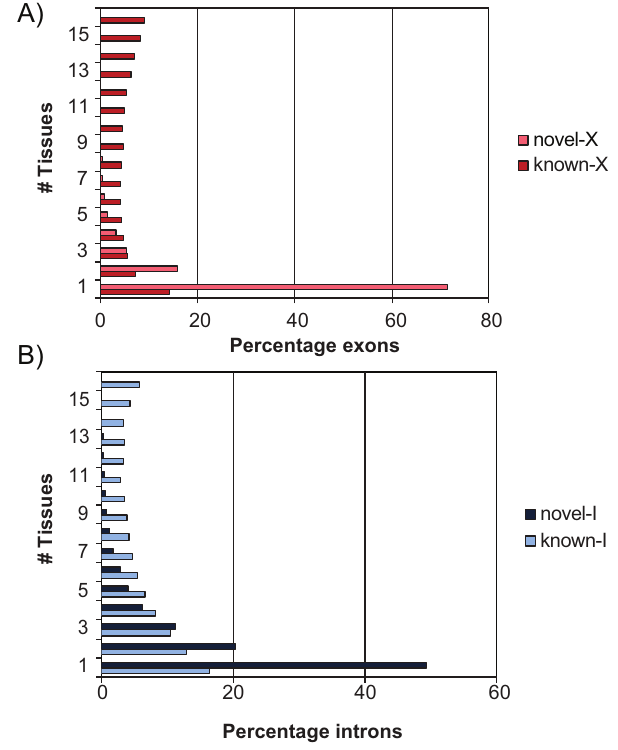
Figure 5. Distribution of novel and known features by the number of tissues in which they occurred. ( A ) The percentage of exons found in 1, 2, …, 16 tissues are shown as horizontal bars, for the 2,914 novel exons (‘novel-X’) and 24,075 known exons (‘known-X’). ( B ) Similarly for the 15,958 novel introns (‘novel-I’) and 11,031 known introns